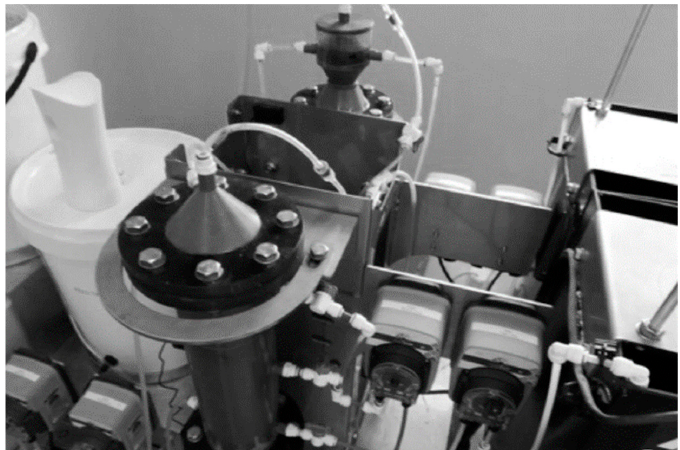
Figure 1. Lab-Scale Treatment Plant for PSW [21]– Reprinted from Membranes, vol 11, Meyo,